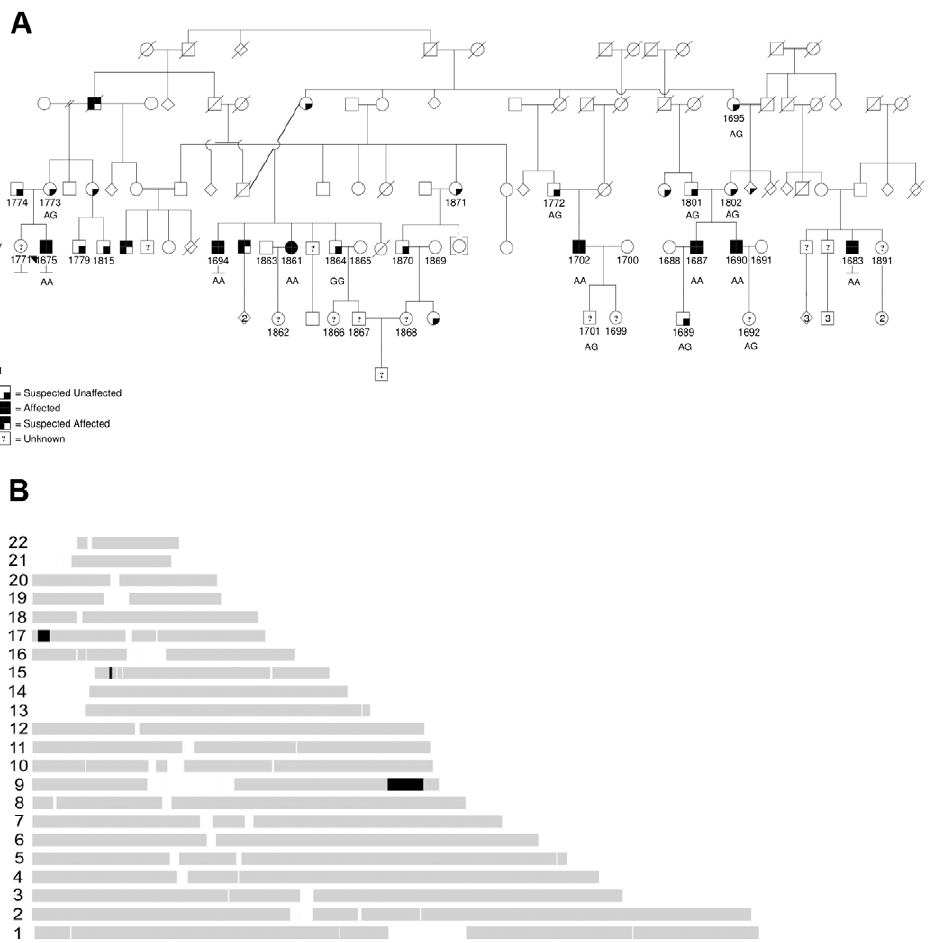
Figure 1. Maritime family with Charcot-Marie-Tooth and genetic mapping. (A) Pedigree, with affected patients shaded in black, sampled individuals have four digit id numbers directly below symbols, proband 1675 is indicated with black arrowhead. Sequenced individuals have mutation status indicated (wild type is GG, homozygous mutant is AA, heterozygous mutant is AG). (B) Homozygous haplotype (HH) analysis. Map of the RCHH intervals shared by 5 patients identified by Homozygosity Haplotype algorithm with a cutoff of 3.0 cM.